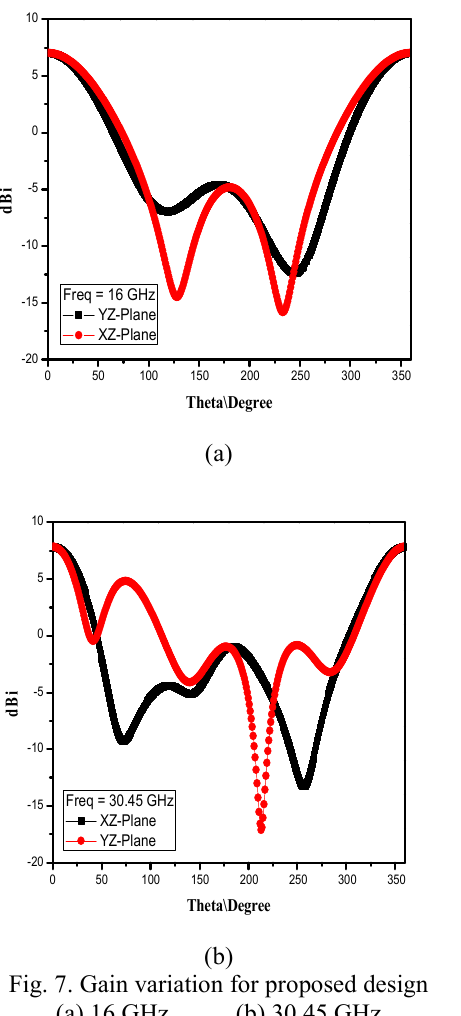
Fig. 7. Gain variation for proposed design